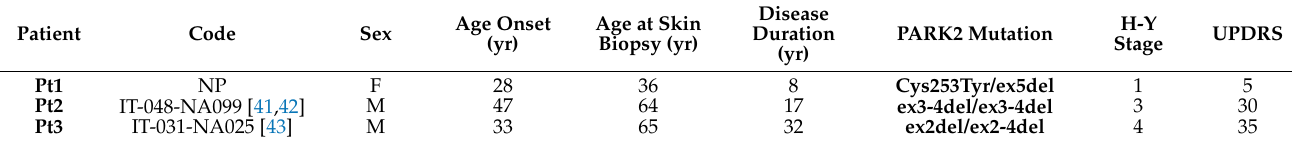
Table 1. Antioxidant activity of sumac extract (SE) and gallic acid (GA). The antioxidant activity was evaluated with DPPH assay and TEAC assay and expressed for both as IC50 (mg/mL) and TE (mmol TE/g extract). Data are expressed as averages of three experiments ± standard deviation. SE and GA means are significantly different for p ≤ 0.05 (Student’s t -test analysis). IC50: half maximal inhibitory concentration; TE: Trolox Equivalents. DPPH Assay TEAC Assay TE IC50 TE IC50 (mmol TE/g) (mg/mL) (mmol TE/g) (mg/mL) SE 1.02 ± 0.05 0.41 ± 0.02 1.76 ± 0.10 0.21 ± 0.005 GA 26.68 ± 1.05 0.016 ± 0.001 29.19 ± 2.55 0.012 ± 0.0003 Table 2. Genotypic characterization and disease severity for the three patients enrolled in this study. Sex, age at PD onset, age at skin biopsy, following the Hoehn and Yahr (HY) and Unified Parkinson Disease Rating (UPDRS) Scales, are indicated. The control is a 53-year-old female. Pt1: patient 1; Pt2: patient 2; Pt3: patient 3; NP: not